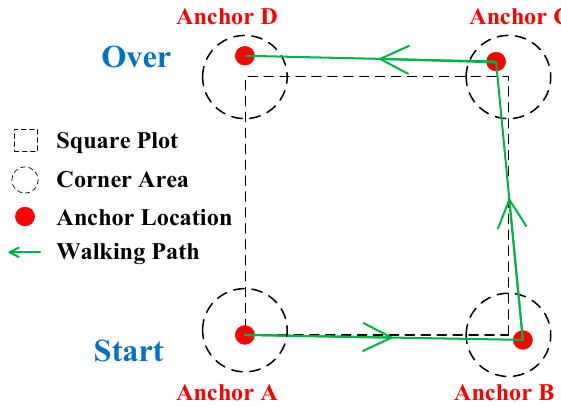
Figure 5. Anchors set up in a square plot.